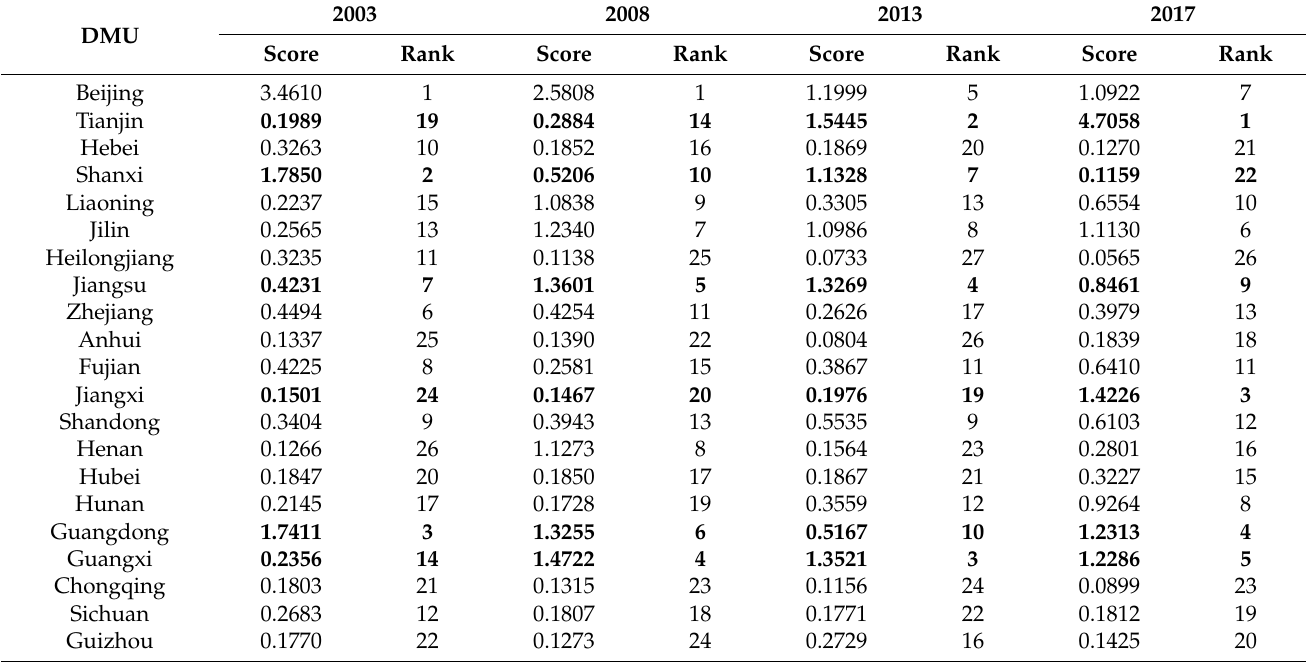
Table 2. Provincial efficiency analysis results of the Super-SBM